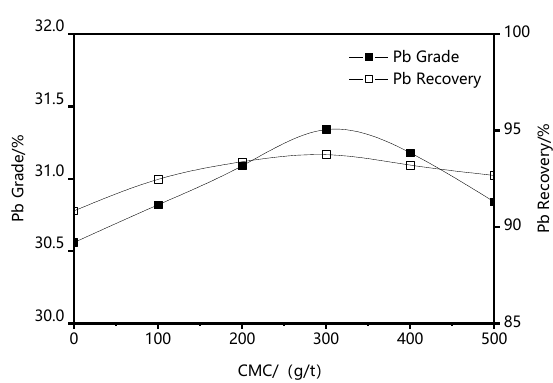
Figure 7. The influence of CMC dosage on Pb rougher flotation.